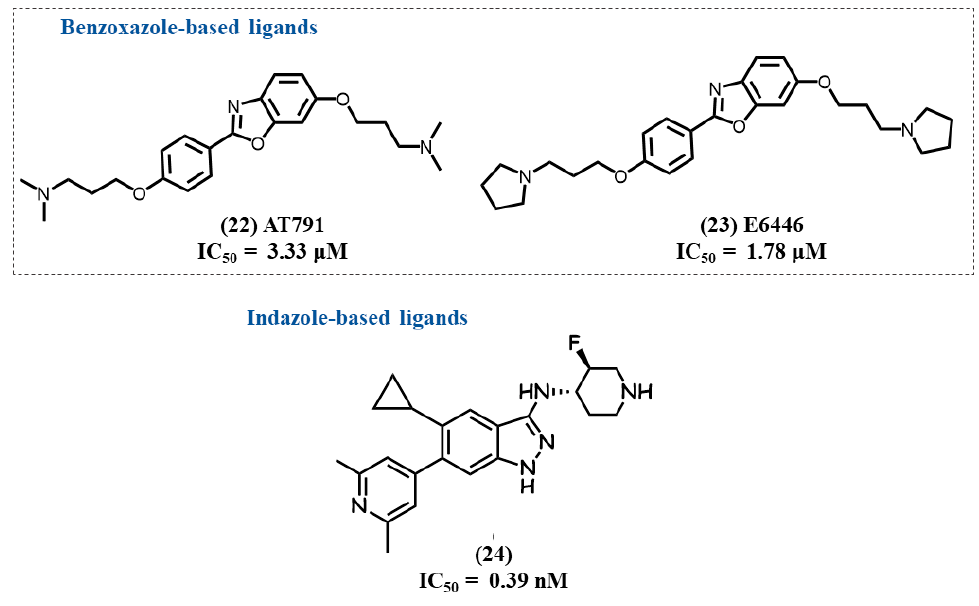
Figure 7. Benzoxazole and indazole